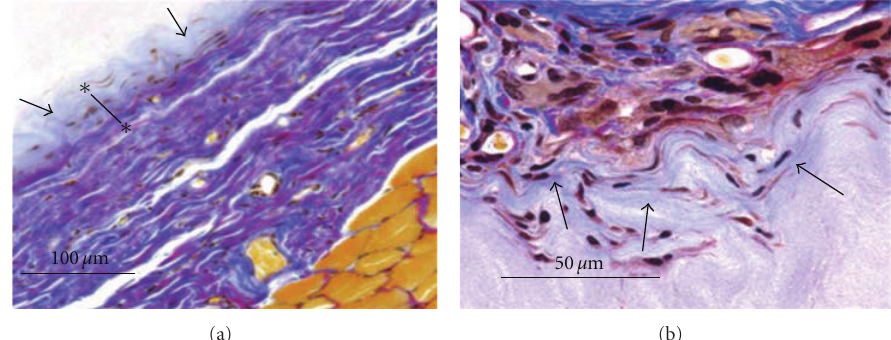
Figure 28: Ladewig’s trichrome staining. (a) The compact side after 12 weeks showing the fibroblasts inside the nanocellulose have synthesized collagen (seen as blue staining; indicated with arrow heads), (b) High magnification of the interface area at the porous side of nanocellulose after 12 weeks (Arrow heads show collagen synthesized by the fibroblasts) [225].